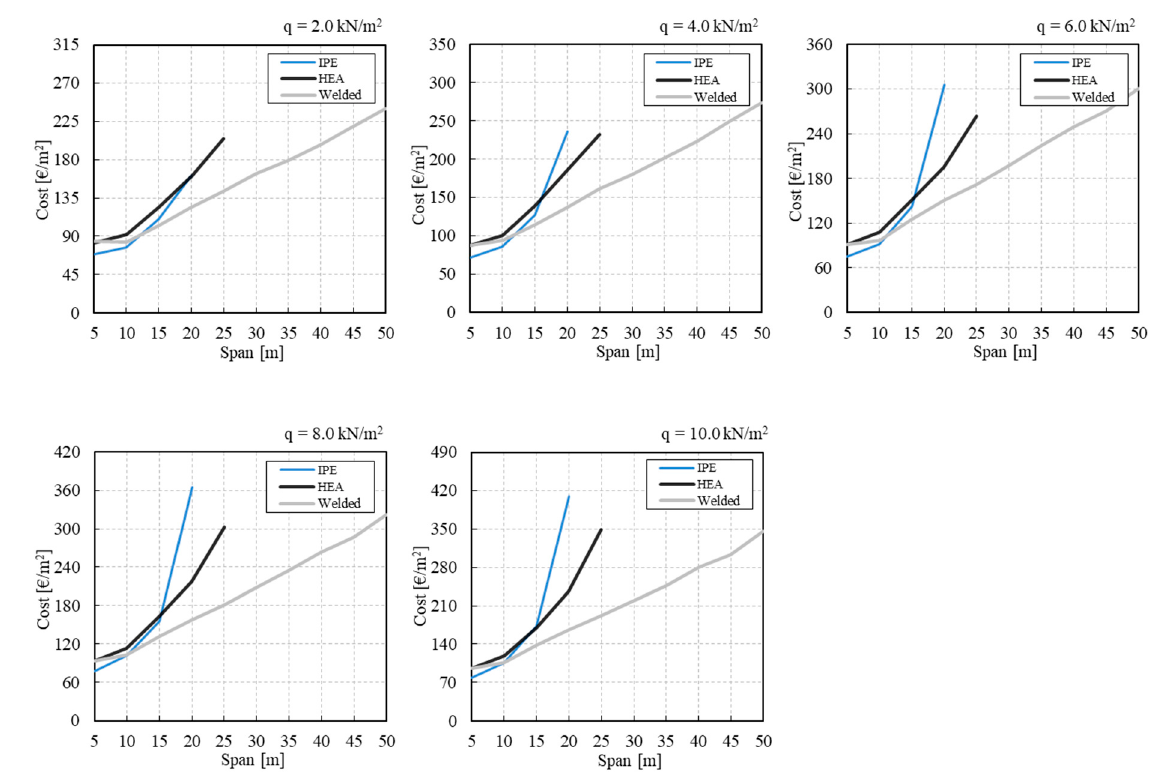
Figure 7. Comparative diagrams of the optimal energy life-cycle costs for the energy efficient case (ELCC EEC) of the CFS structures with welded and standard IPE and HEA sections.